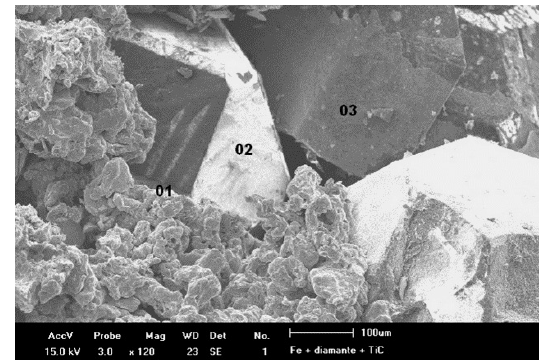
Figure 15. Micrograph of Fe-TiC coated diamond composite after compression tests. Points 1 to 3 are regarded to EDS analyses.